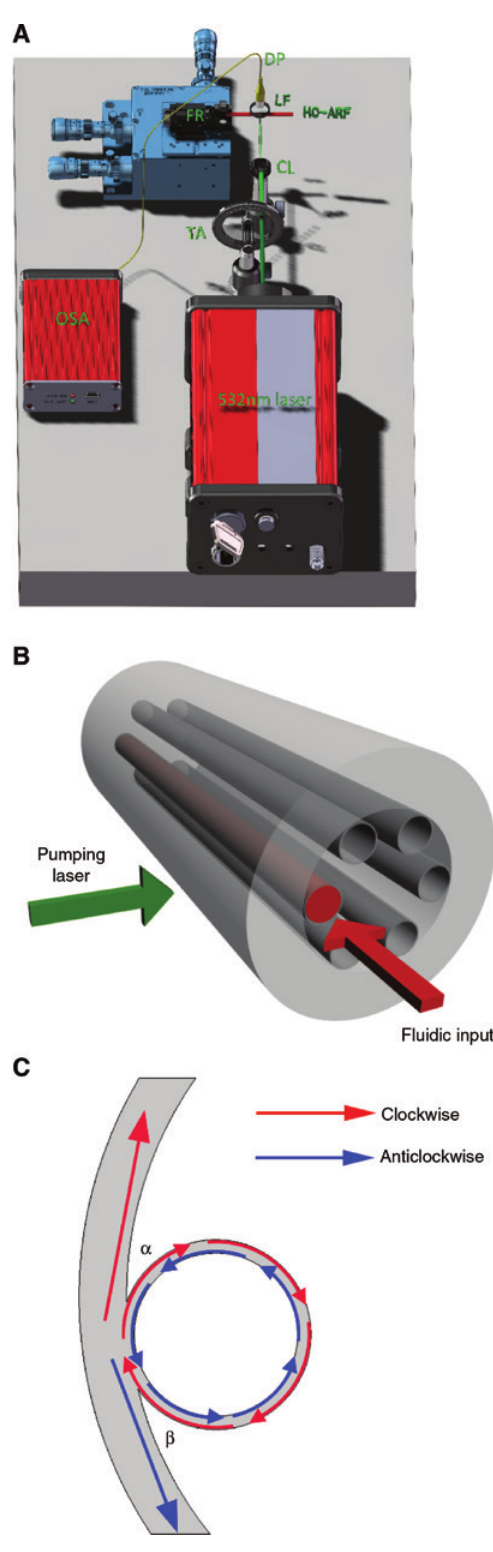
Figure 3: Schematic diagrams of the experiment layout, HC-NCF and microring resonator. (A) Schematic diagram of the experimental layout. (B) Enlarged schematic diagram of a part of the HC-NCF. (C) Schematic diagram of the microring resonator contacting with the fiber